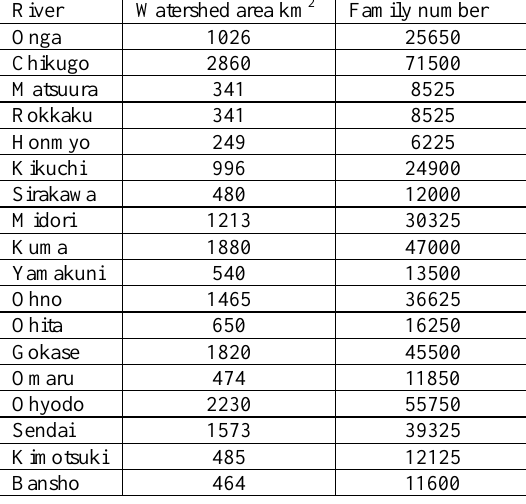
Table 2. List of Kinki rivers